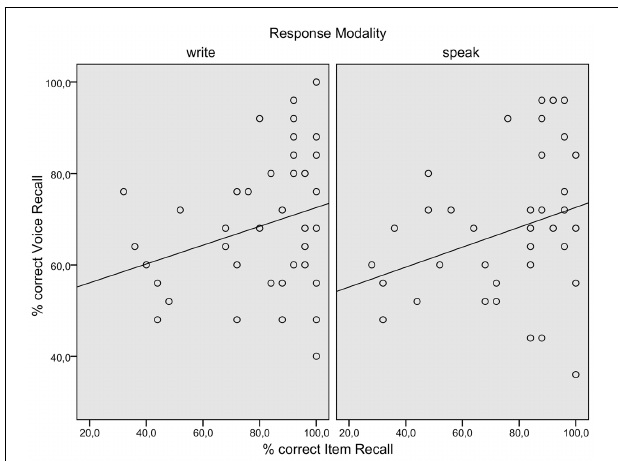
FIGURE 6 | Experiment 3. Individual episodic information (associate word spoken with male or female voice) recall performances plotted against associate word (item) recall